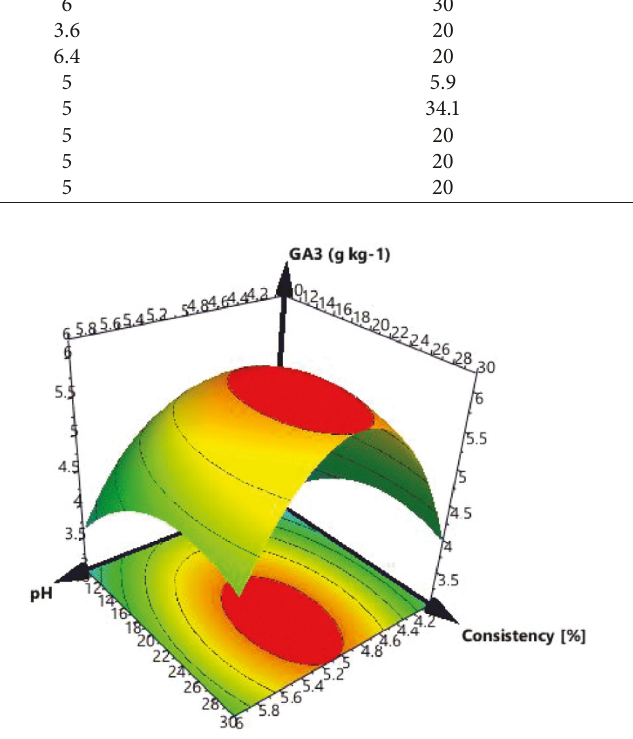
Figure 2: Response surfaces for the amount of GA 3 produced from corn cob upon variation in the pH and sample consistency